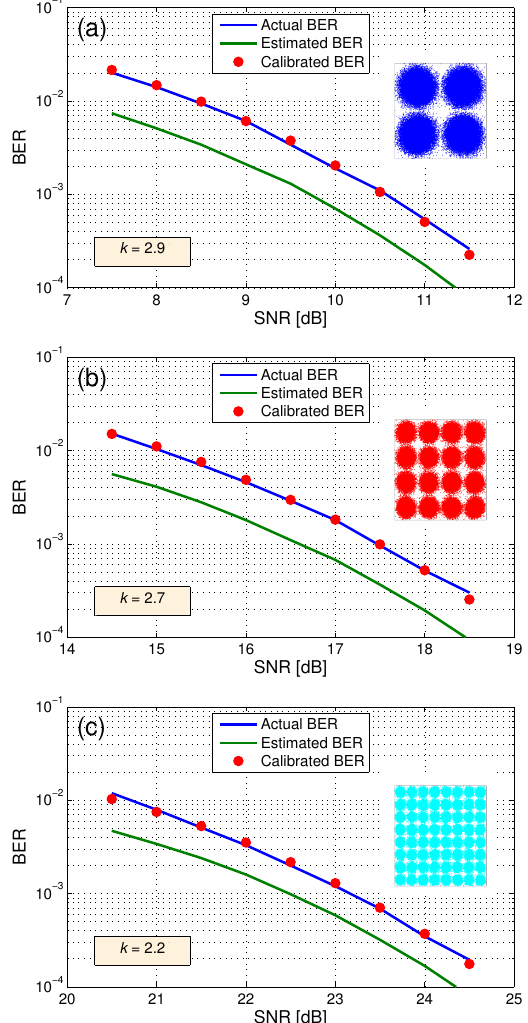
Figure 4. Performance of estimated and calibrated BER from EVM analysis for: ( a ) quadrature phase shift keying (QPSK) ( ∆ ν · T s = 10 − 4 ); ( b ) 16-QAM ( ∆ ν · T s = 10 − 4 ); ( c ) 64-QAM ( ∆ ν · T s = 10 − 5 ).